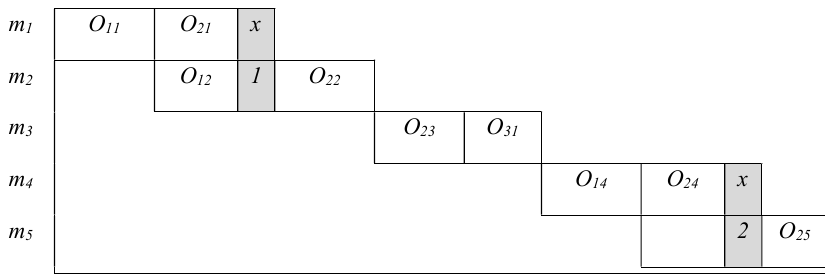
Fig. 5. NPFS schedule of 2 jobs and 5 machines, with two switching machines ( m 2 and m 3